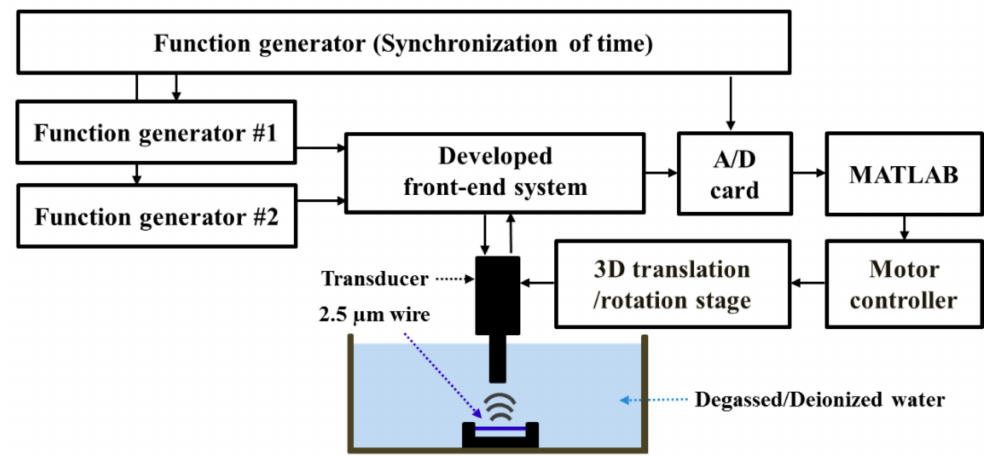
Figure 3. High frequency mechanical ultrasound system